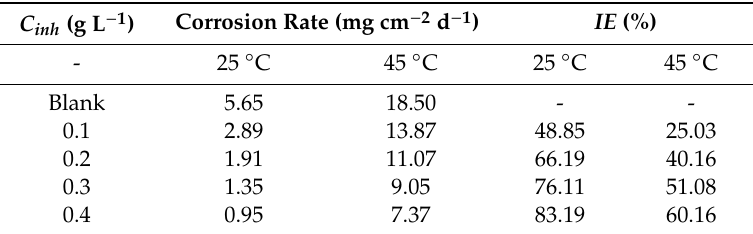
Table 1. Corrosion rate and inhibition e ffi ciency obtained from weight loss measurements for pure aluminium at various concentrations of GG after 24 h of immersion at 25 and 45 ◦